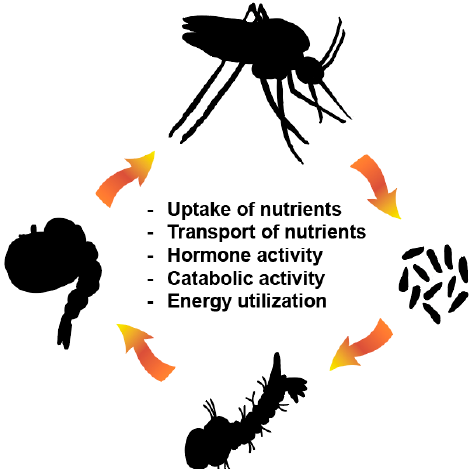
Figure 1. Metabolism of dietary and stored nutrients is critical for each stage in the mosquito life cycle and provides an opportunity to design next-generation insecticides that have minimal off-target effects. Next-generation insecticides can be developed that inhibit uptake of nutrients, transport of nutrients, hormone activity, catabolic activity, and energy utilization pathways.